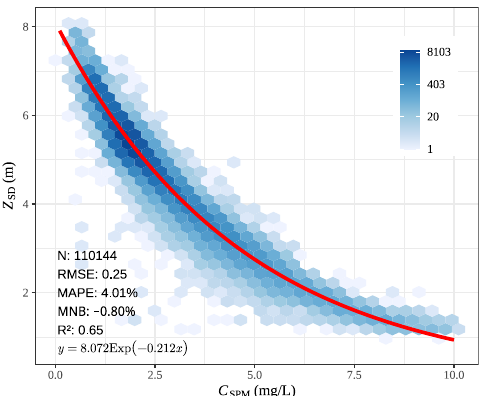
Figure 6. Daily and monthly mean variation of the Z SD ( a ) and C SPM ( b ) in Qinghai Lake.